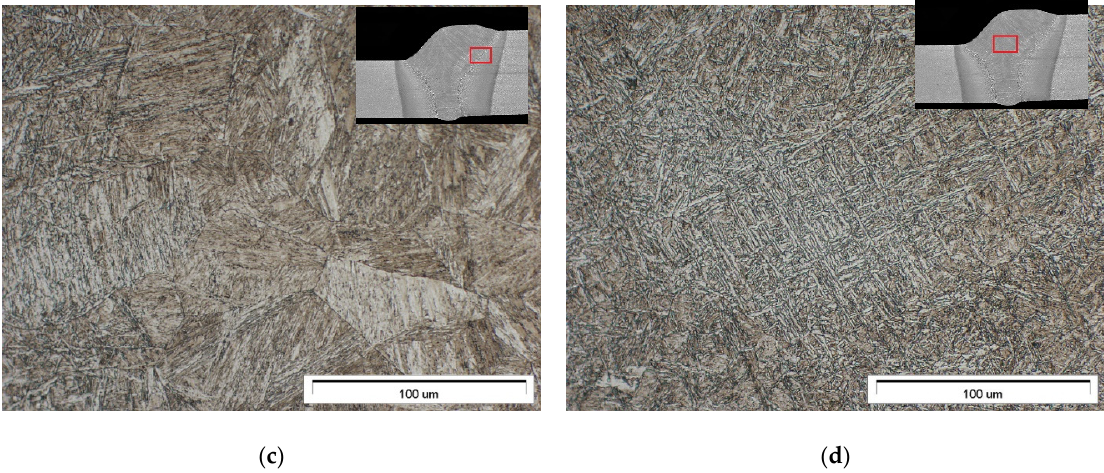
Figure 9. Structure of hybrid-welded joint no. 1 made of steel S960QL: ( a ) macrostructure, HAZ, and the weld; ( b ) fine-grained martensite in the base material; ( c ) HAZ containing coarse-grained martensit; ( d ) weld—martensitic structure.